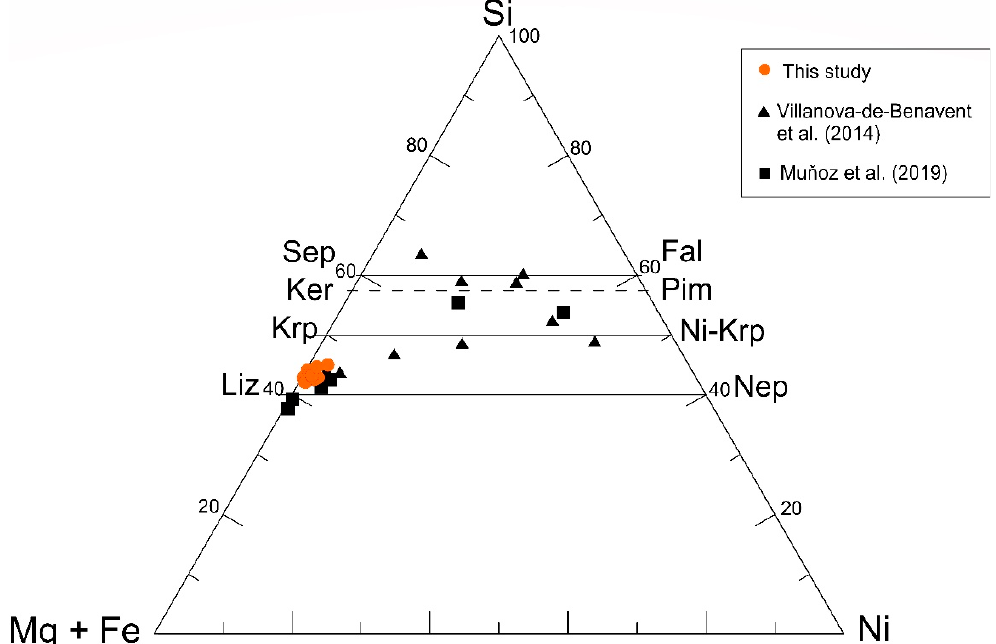
Figure 12. Si-Mg-(+Fe)-Ni plot showing the composition of serpentine-like garnierite in this study and previous works. Lz—lizardite, Nep—népouite, Krp—karpinskite, Ni-Krp—Ni-karpinskite, Ker—kerolite, Pim—pimelite, Sep—sepiolite, Fal—falcondoite.